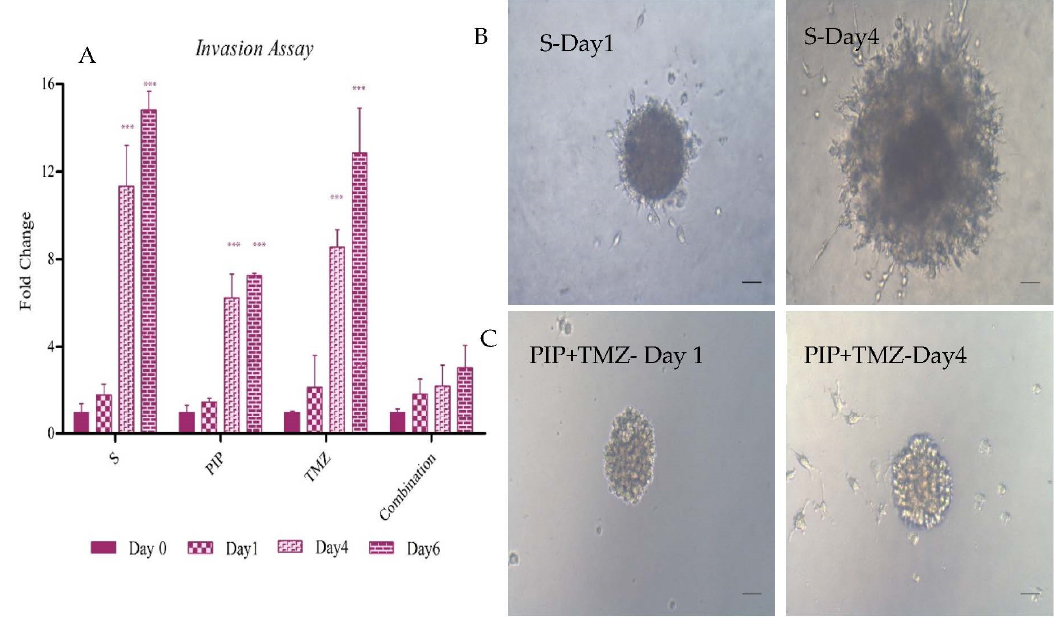
Figure 14. The effect of survivin inhibition on invasion. ( A ) The effect of PIP, TMZ and combination on invasion in the GSC population from day 0 to day 6. ( B , C ) Representative images of migrating spheres on Geltrex. ( B ) Images for control cells on Day 1 and Day 4, respectively. ( C ) The images of combination of 25 μ M PIP and 37.5 μ M TMZ on Day 1 and Day 4, respectively. The graphical data are presented as mean ± SD, and the statistical analysis was performed using one ‐ way ANOVA (***: p ‐ value < 0.001). The scale bar indicates 20 μ m.